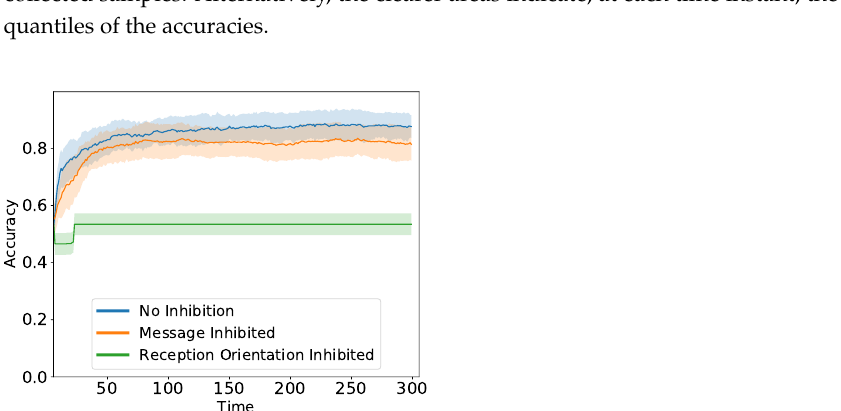
Figure 16. Temporal evolution of the accuracy of the robot’s classification in the borderline identifi- cation experiment for different inhibited variables. It compares the accuracy in a situation without inhibition (blue) and inhibiting different communication variables (one by